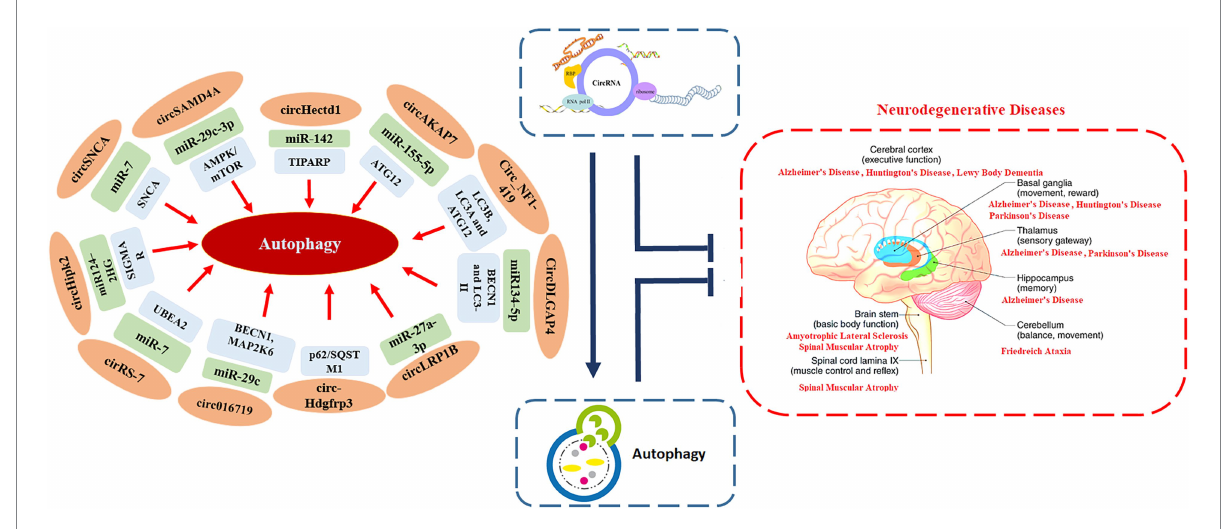
FIGURE 1 The interplay between circRNAs, autophagy and